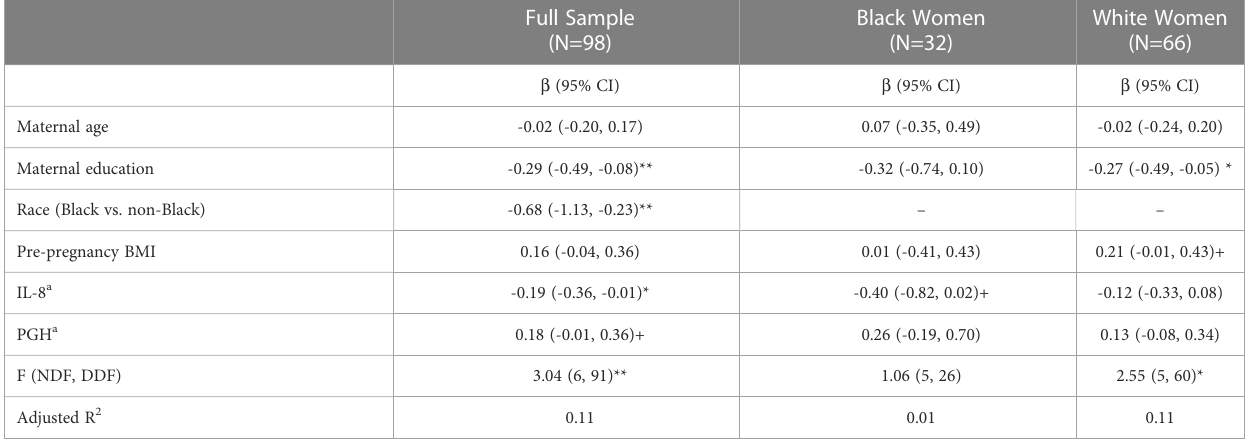
TABLE 5 Multiple linear regressions of BWz in full sample and strati fi ed by race.